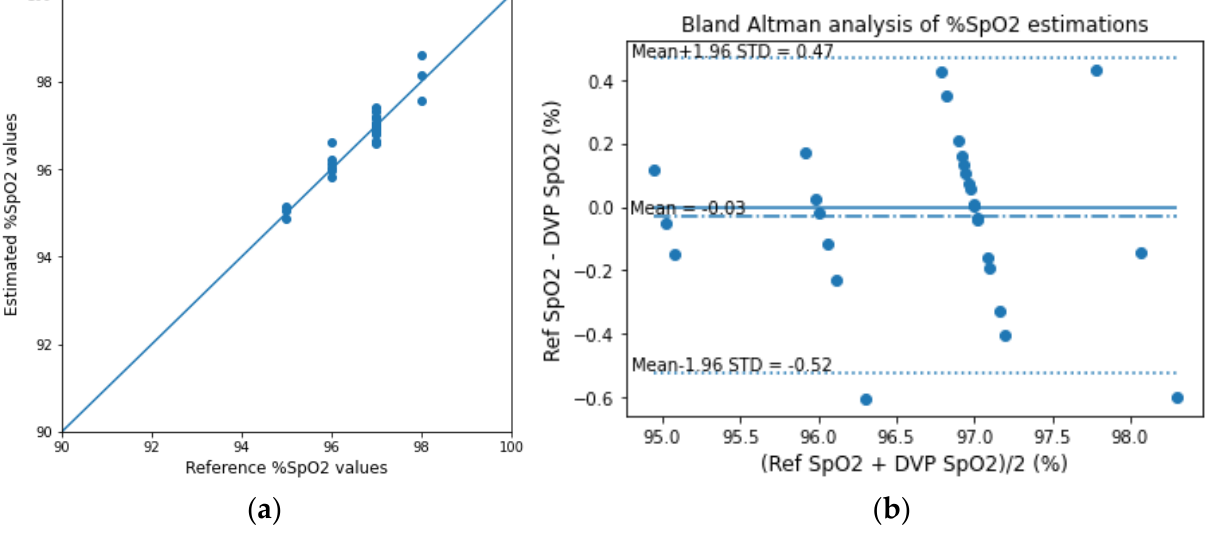
Figure 23. ( a ) Scatter plot for the reference and estimated SpO 2 values and ( b ) the Bland – Altman